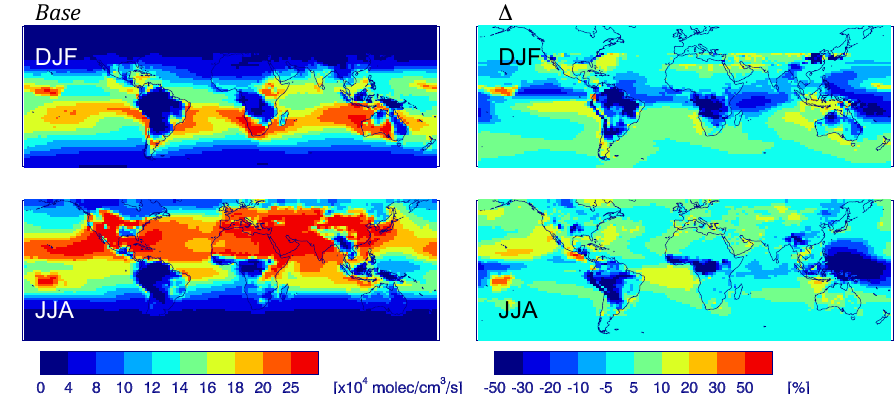
Figure 17. Seasonal mean (1988–2007) and mass-weighted tropospheric methane loss rate (left column; × 10 4 moleculescm − 3 s − 1 ) with the relative difference with the AllVary scenario (( Base – AllVary ) / Base ; right column).